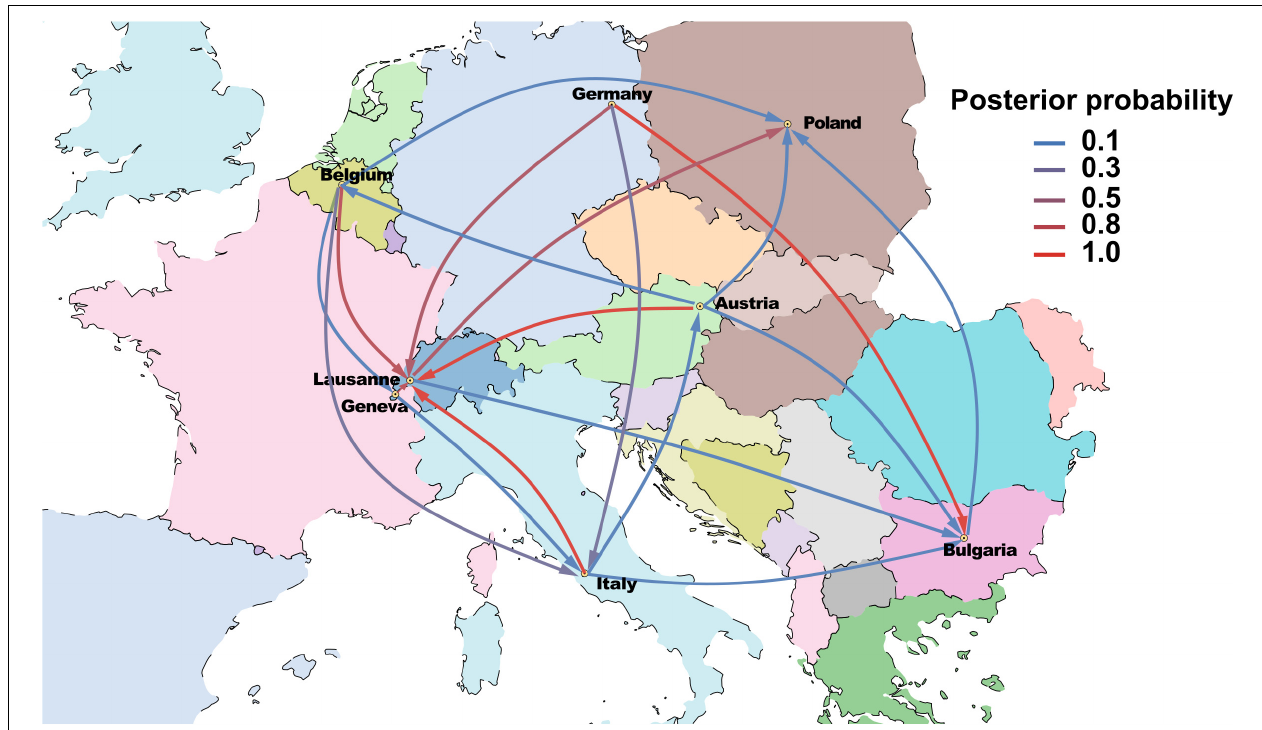
FIGURE 4 | Phylogeographic reconstruction of ST228 representing the various transmission events among European countries. Lines are colored according to posterior probability support and arrows represent the general direction of the expansions.